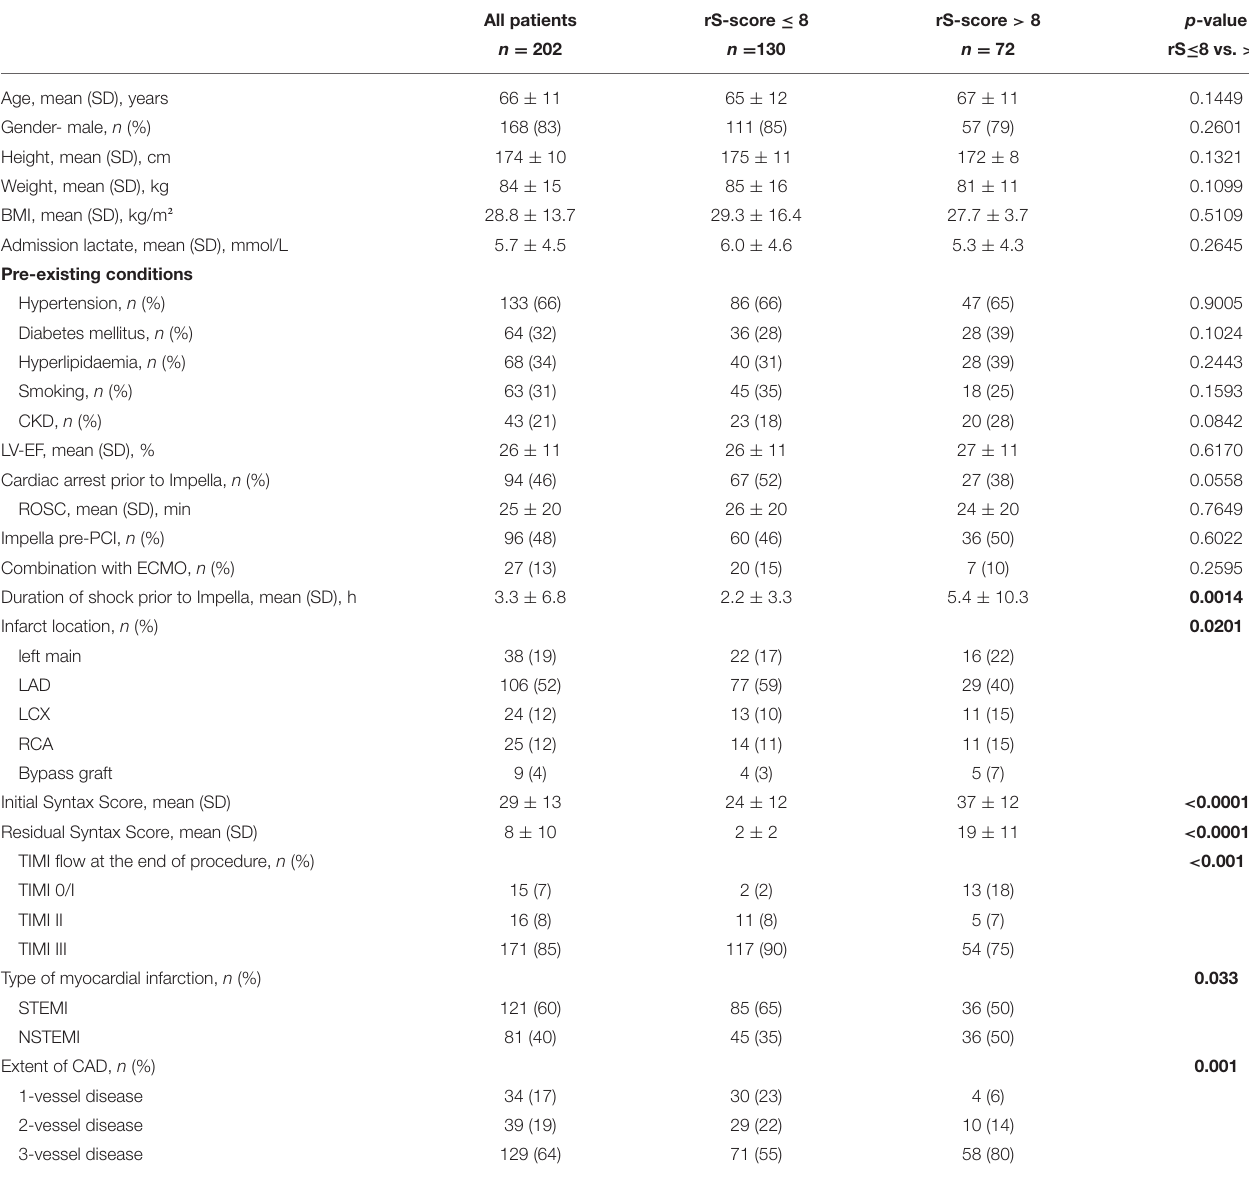
TABLE 1 | Baseline and procedural characteristics of the present prospective cohort.